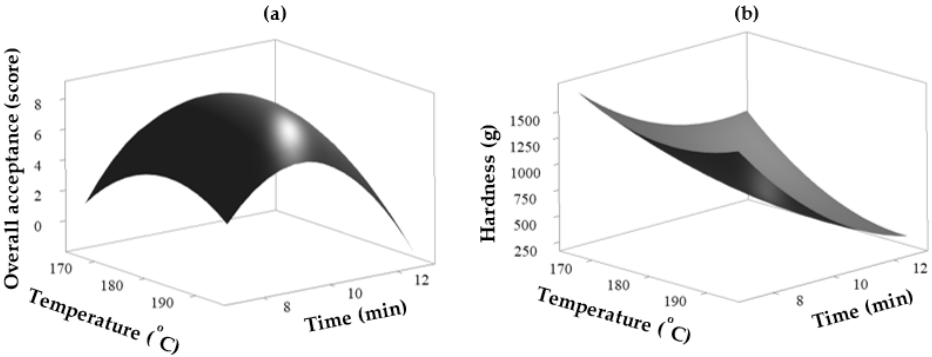
Figure 3. Response surface graph developed from RSM for ( a ) overall acceptance (score) and ( b ) hardness (g) of braised mackerel with radish at the designated superheated steam roaster temperature (°C) and time (min). At temperatures of over 180 °C for more than 10 min, the braised mackerel with